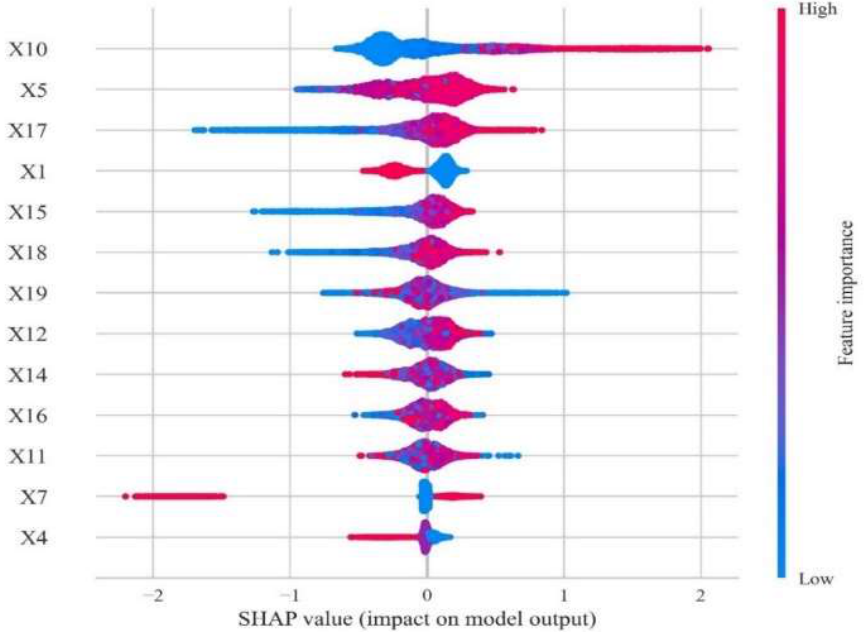
Figure 4. SHAP summary diagram of domestic advanced students.